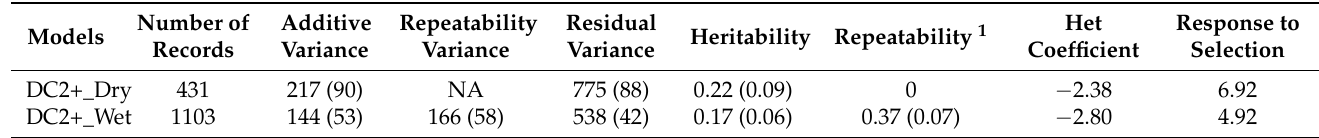
Table 9. Variance components, heritability and heterozygosity coefficient of days to calving (J2+) split